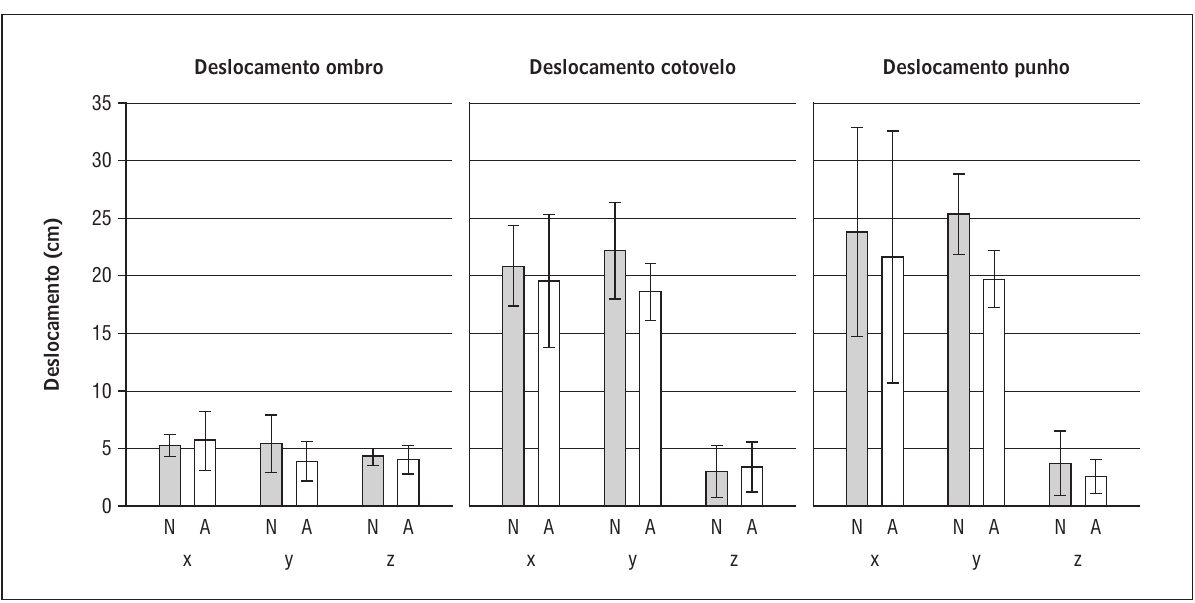
e acometido Legenda: N = lado não acometido; A = lado acometido.